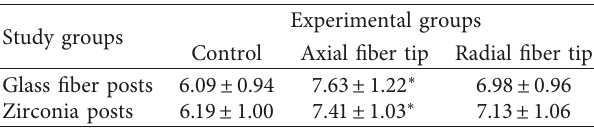
Table 2: Overall push-out bond strength values of the different post groups expressed in MPa ( ± SD).